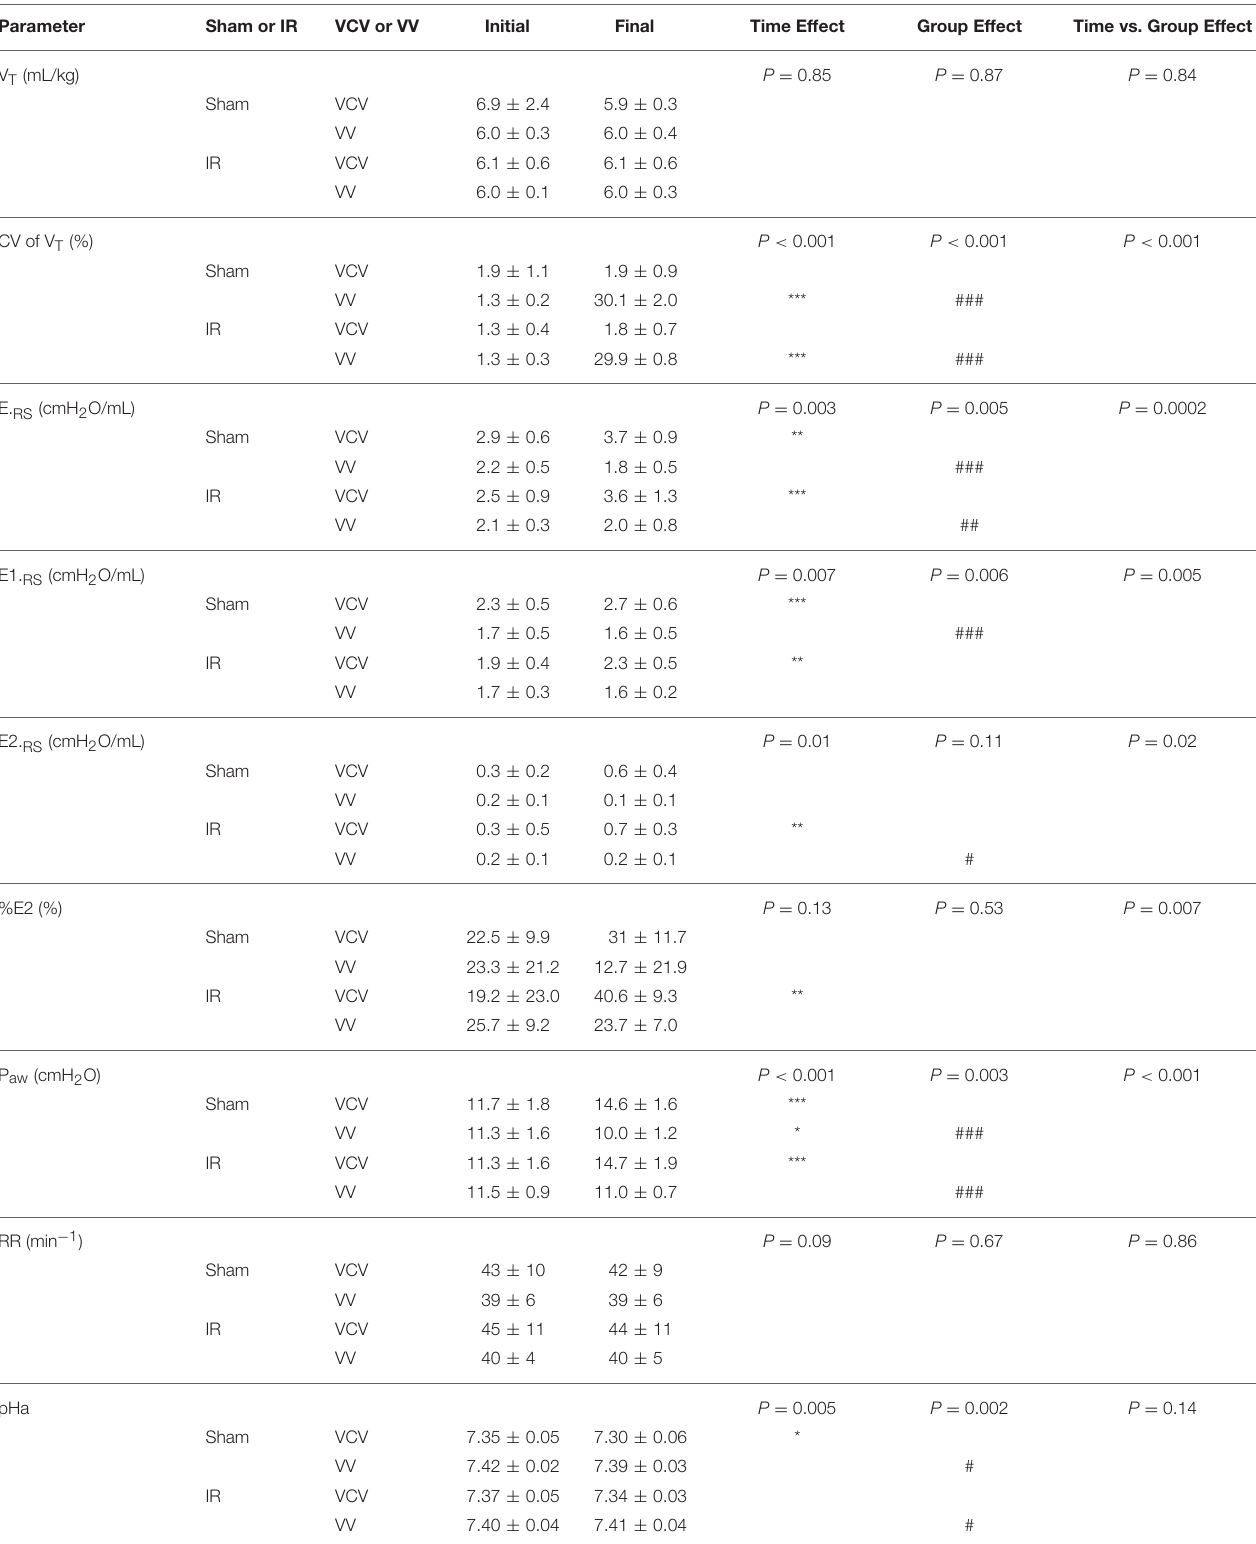
TABLE 1 | Respiratory parameters during mechanical ventilation. Parameter Sham or IR Initial Final Time Effect Group